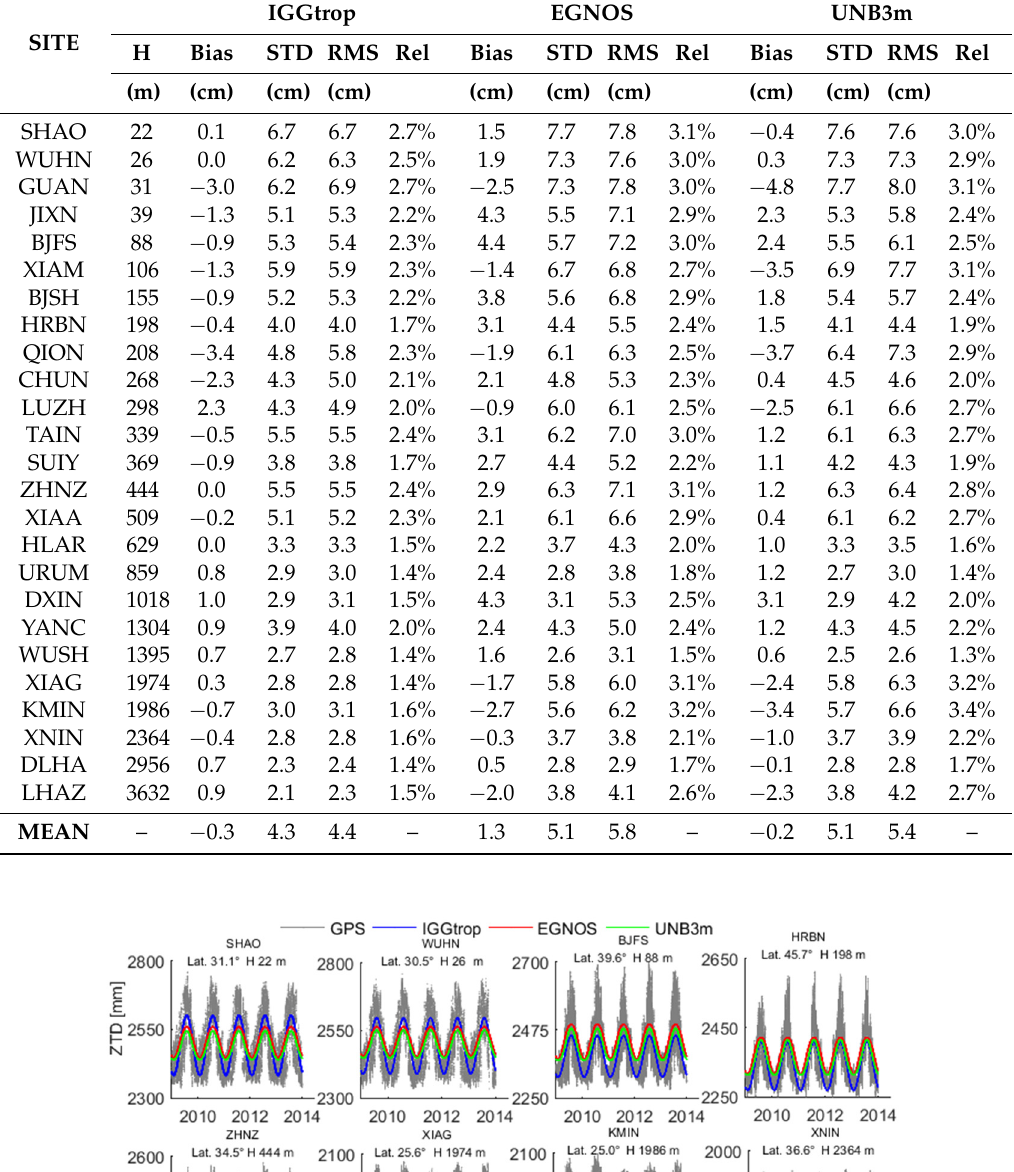
Table 1. Statistics of ZTD estimation errors (Bias, STD, RMS and relative errors) for the IGGtrop, EGNOS and UNB3m models at 25 stations in China during the period 2009–2013.